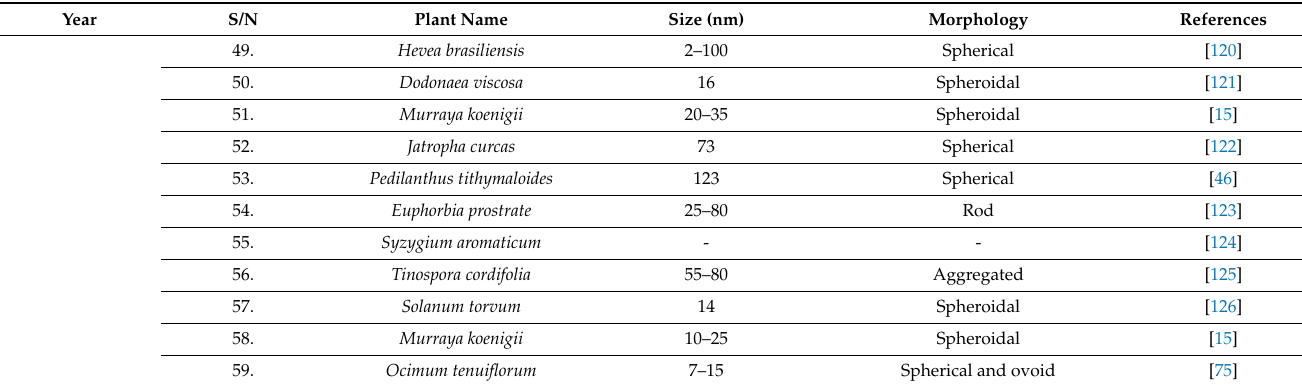
3 with phytochemicals